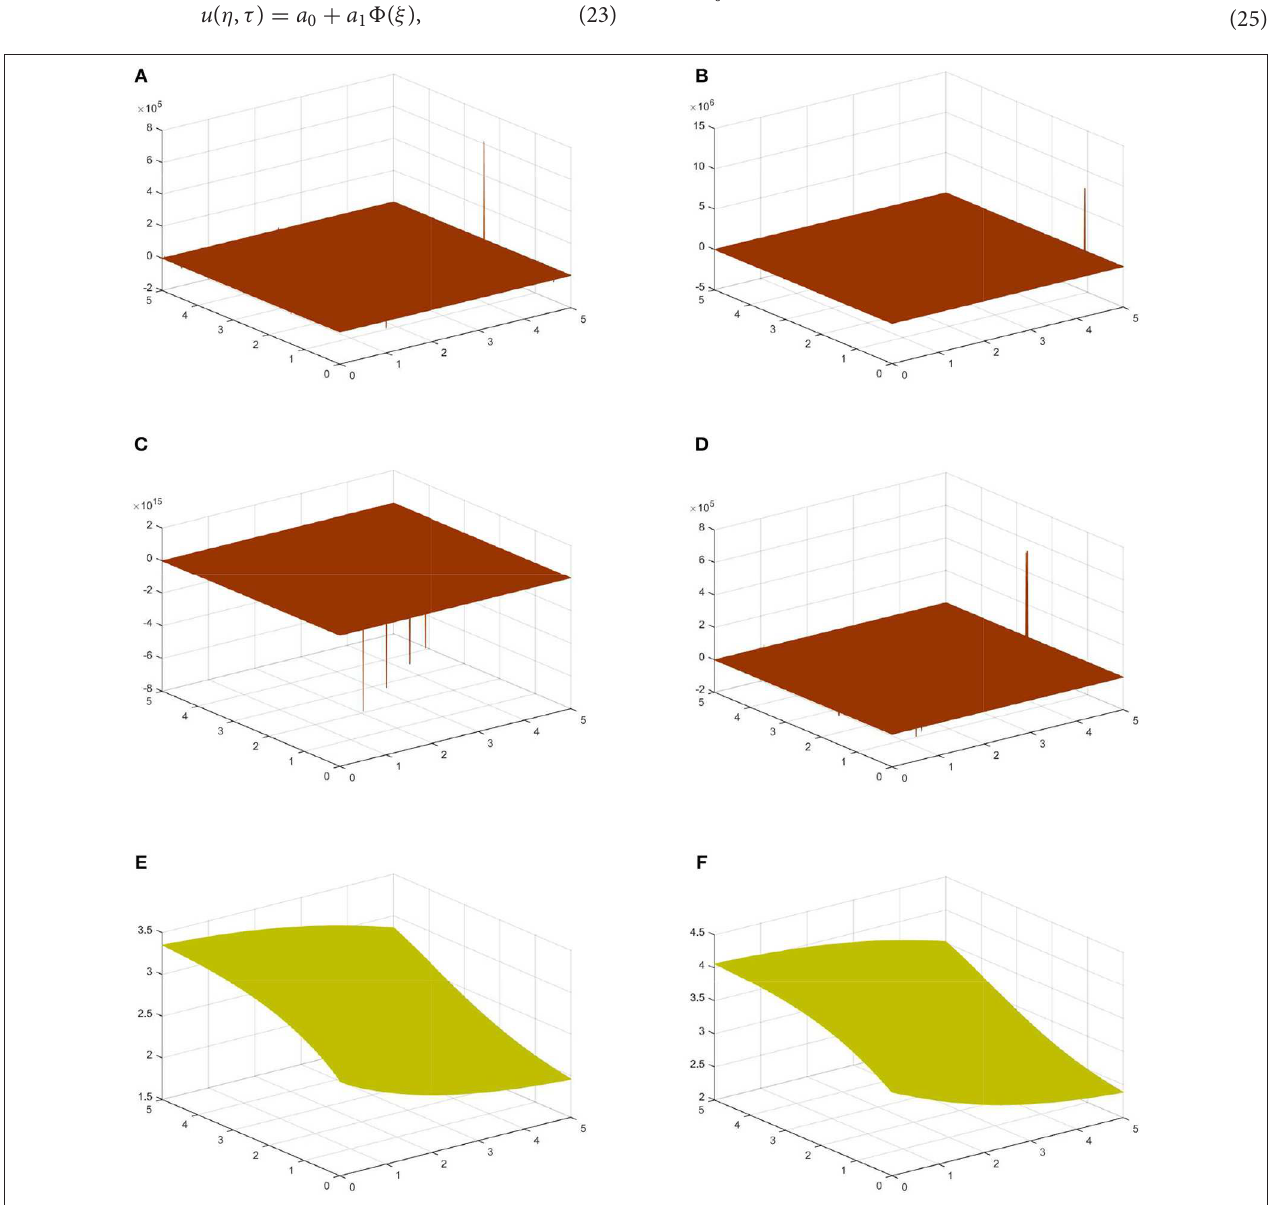
FIGURE 2 | Physical features with suitable values of the parameters. (A) M-truncated with γ M-truncated with γ